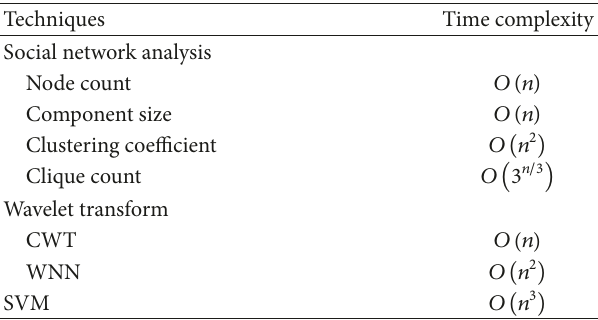
Table 5: Time complexities for each